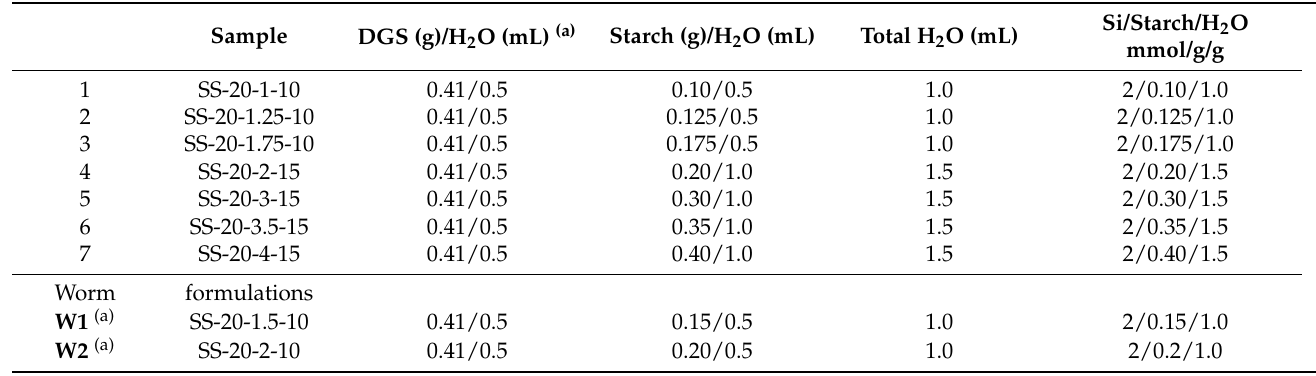
Table 1. Sample preparation conditions.